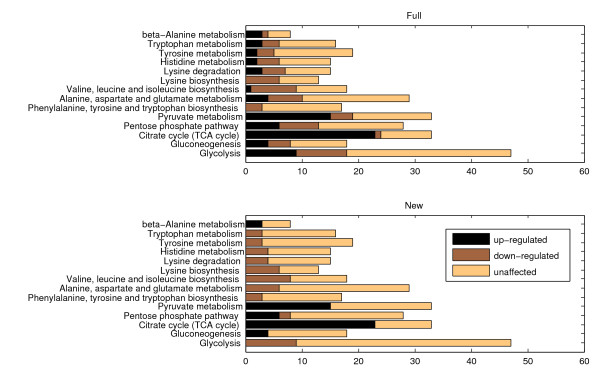
Full membership and Hill climbing produced allocation. The figure reveals the number of up-, down-regulated and stable genes in each of the sample pathways before and after processing. In the first case (top) entitled full, we assume that multi-membership genes are functional in all pathways of which they are members, while in the second case (bottom) the data has been subjected to processing with the hill climbing search method.